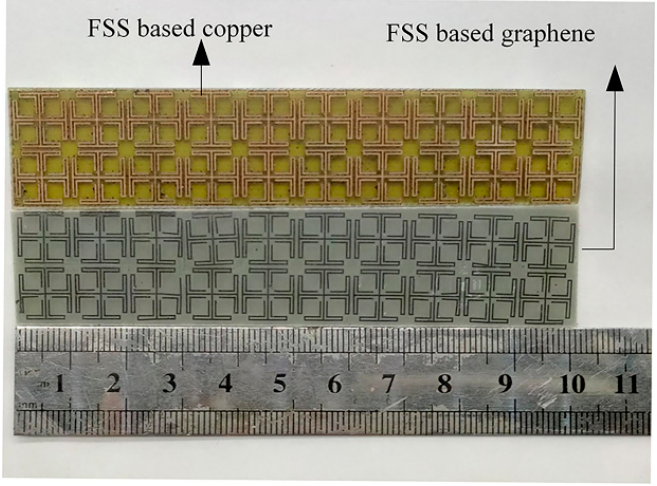
Figure 4. The prototypes of graphene film FSS structure after laser-engraving. The performance of the proposed FSS is measured by the space method in the anechoic chamber. As shown in Figure 5, the network analyzer (PNA, Keysight N5247A) is connected to the standard horn antenna at both ends. The two antennas are placed opposite each other horizontally, and a 60 × 60 cm 2 copper plate is placed in the middle. The center of the copper plate has a hollow area of 20 × 20 cm 2 where the FSS under test (FUT) is placed, and the rest of the area is filled with absorbing materials. The transmission coefficient of FUT is obtained by calculating the difference of the |S 21 | with FUT and without FUT. As shown in Figure 6, the measured result is in good agreement with the simulated result. Furthermore, a feature selective validation (FSV) method, which is a central technique to compare different datasets [30], was applied to give a statistical comparison between the simulated and measured results. A GRADE value of 3 and SPREAD value of 2 were obtained, demonstrating the good agreement. Moreover, the proposed FSS exhibit high efficiency in suppressing the electromagnetic wave transmitting at 3.5 GHz.